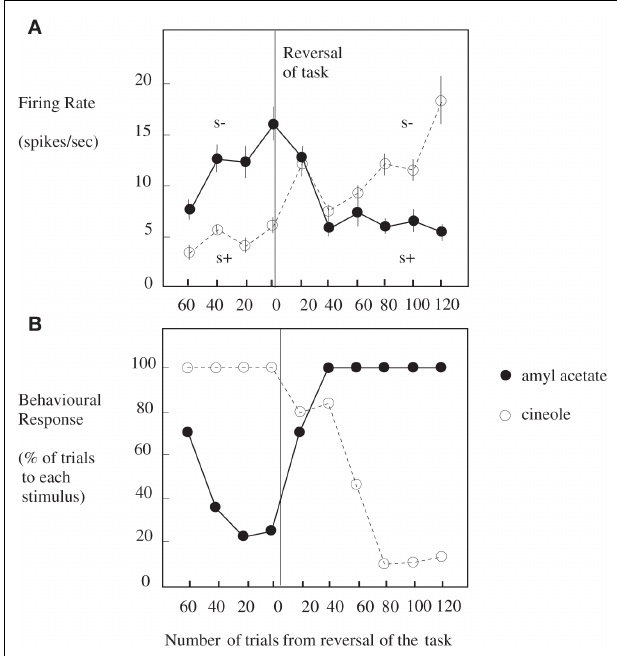
FIGURE 2 | Orbitofrontal cortex: olfactory-to-taste association reversal. (A) The activity of a single orbitofrontal cortex olfactory neuron during the performance of a two-odor olfactory discrimination task and its reversal is shown. Each point represents the mean poststimulus activity of the neuron in a 500-ms period on approximately 10 trials of the different odorants.The SE of these responses are shown.The odorants were amyl acetate (closed circle; initially S − , punished with a taste of salt) and cineole (o) (initially S + , rewarded with fruit juice flavor). After 80 trials of the task the reward associations of the stimuli were reversed.This neuron reversed its responses to the odorants following the task reversal. (B) The behavioral responses of the monkey during the performance of the olfactory discrimination task.The number of lick responses to each odorant is plotted as a percentage of the number of trials to that odorant in a block of 20 trials of the task. (After Rolls et al.,